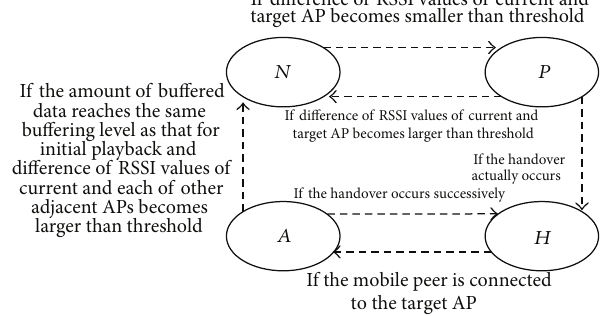
Figure 1: State transition diagram for handover behavior.